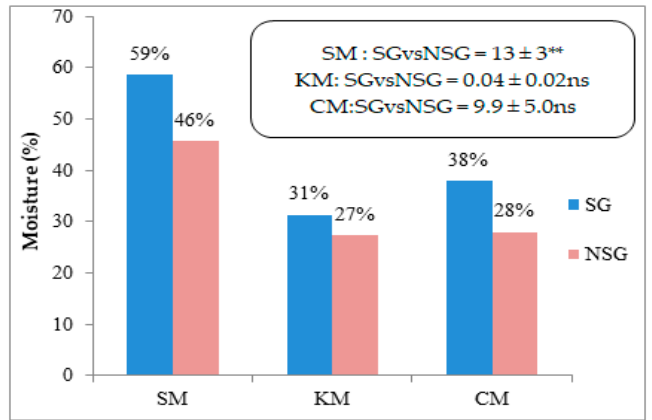
Figure 6. Moisture content in the stover (SM), kernels (KM), and cobs (CM) moisture of 8 maize SG and 8 NSG lines at harvest, evaluated in 2017 in two locations in Galicia. SG: stay-green lines. NSG: non-stay-green lines. ** significant at p -value ≤ 0.01; ns: no significant.